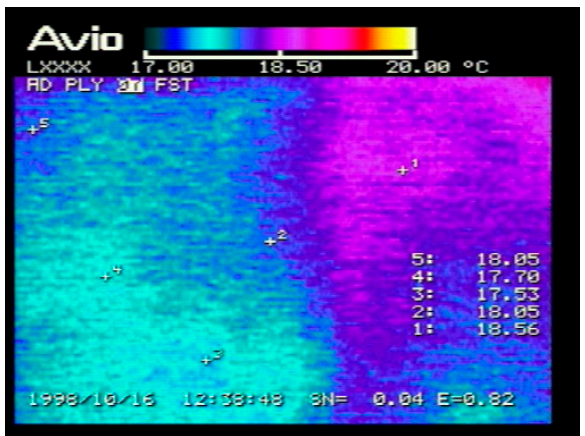
Figure 17. Thermal image of White Pentelic marble surface.